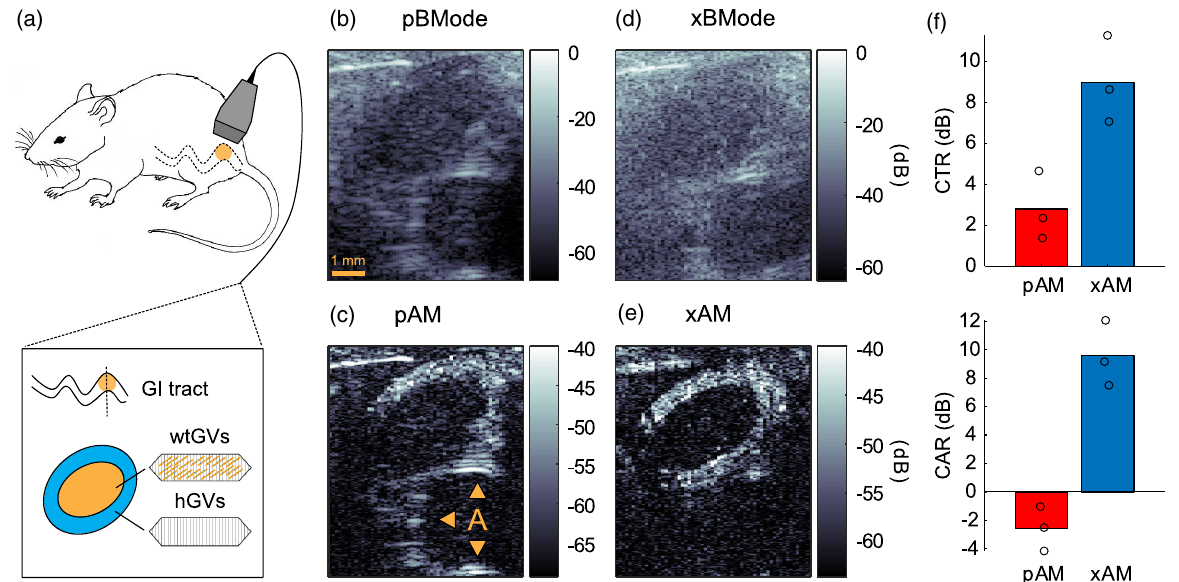
FIG. 6. In vivo pAM and xAM imaging of acoustic biomolecules. (a) Schematic of the experiment. A concentric mixture of nonlinearly scattering hGVs and linearly scattering wtGVs is injected in a mouse gastrointestinal (GI) tract and imaged with pAM and xAM. (b) pBMode image, focus ¼ 4 mm, f − number ¼ 2 . 0 . (c) pAM image, arrows point to the artifact (A). (d) xBMode, θ ¼ 19 . 5 °. (e) xAM image. The pAM and xAM dynamic ranges are displayed relative to their respective BMode ranges. All image depths range from z ¼ 2 mm to Z X ¼ 9 . 2 mm. (f) Comparison of xAM and pAM in terms of mean CTR and CAR. N ¼ 3 . ROIs for CTR and CAR measurements are reported in Fig. 8, Appendix [Fig. 6(c)]. The pAM image also contains a large artifact below the inclusion (CTR ¼ 2 . 8 dB, CAR ¼ − 2 . 6 dB),